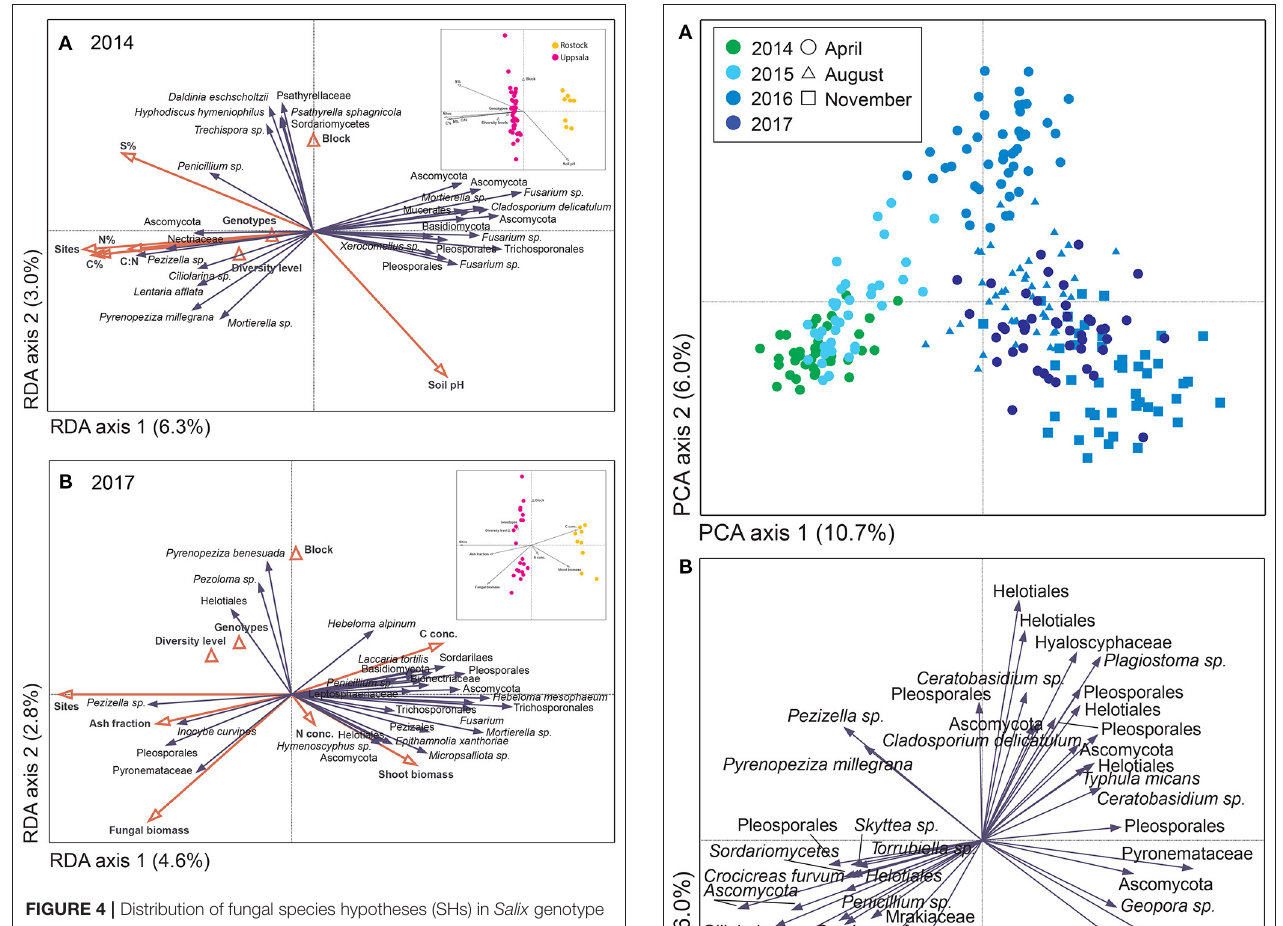
FIGURE 4 | Distribution of fungal species hypotheses (SHs) in Salix genotype trials in Uppsala and Rostock in (A) 2014 and (B) 2017, as visualized by species plots of redundancy analyses (RDA) based on PacBio sequencing of amplified ITS2 markers. The RDAs included 442 (Uppsala) and 217 (Rostock) identified SHs, but only the 30 most abundant fungal species are shown. The triangles and red vectors represent constraining environmental variables. In 2014, axes 1 and 2 explained 6.3 and 3.0%, respectively, of the total inertia of 13,296. N%, C%, S%, and C:N ratio correspond to soil properties. In 2017, axes 1 and 2 explained 4.6 and 2.8%, respectively, of the total inertia of 20,250. N- and C-concentrations and ash fraction correspond to litter chemistry from a litter decomposition experiment. Explanatory variables accounted for 22.9% (2014) and 19.9% (2017). Inserts show sample plots of the RDAs.